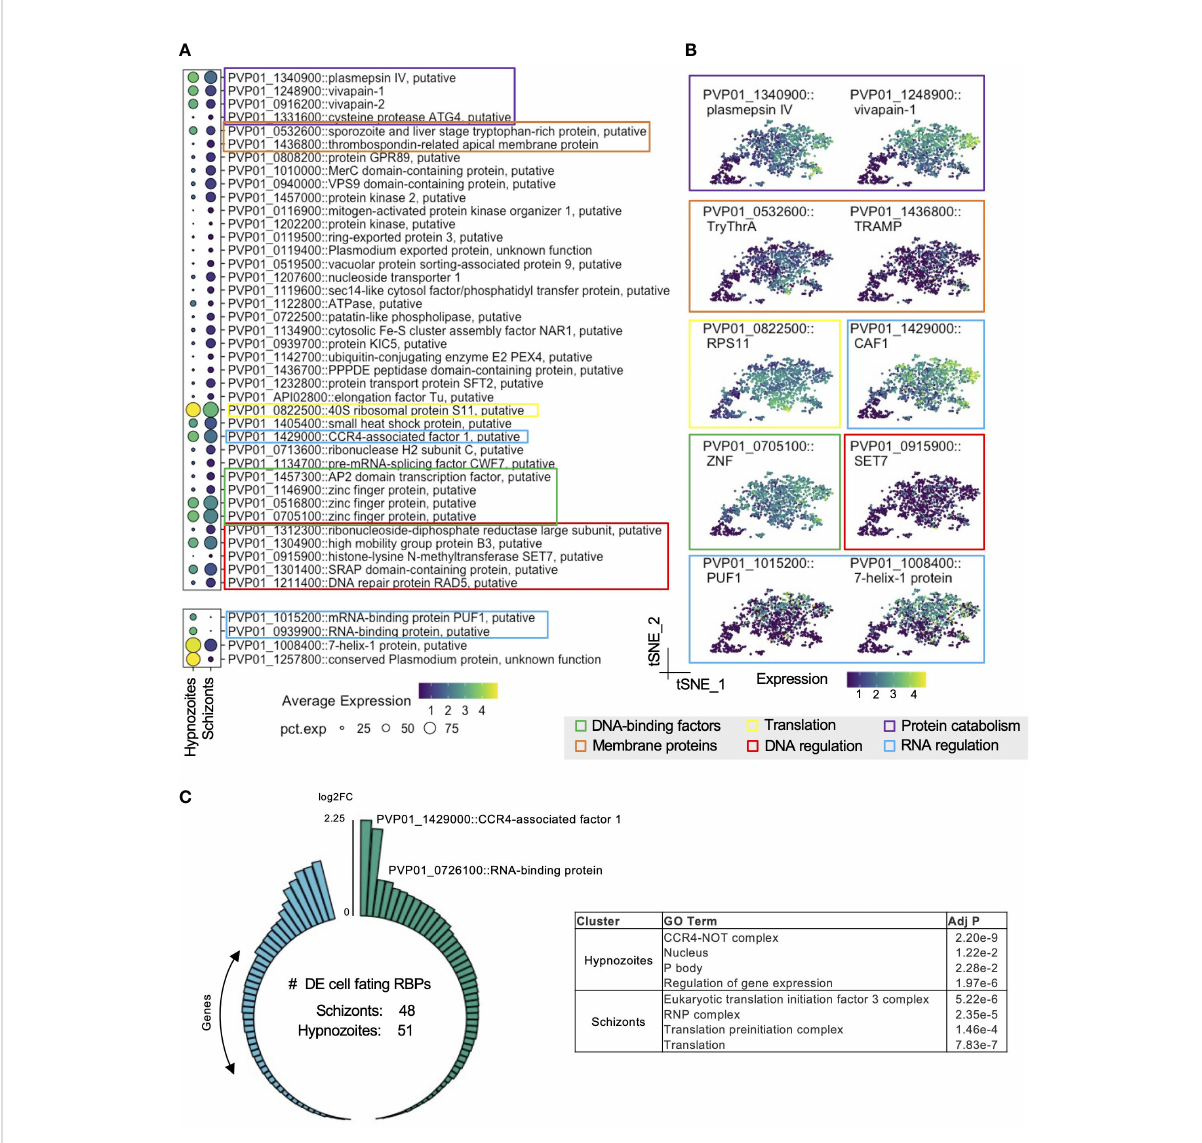
FIGURE 3 P. vivax hypnozoites have distinct transcriptomic signatures. (A) Dot plots showing transcripts that distinguish all hypnozoites from schizonts. The size of the dot corresponds to the percentage of cells that transcript was detected per condition, colored by average expression. Differentially expressed transcripts were identi fi ed using Seurat ’ s FindMarker function (Wilcoxon rank-sum test, Bonferroni adjusted p values < 0.01). (B) tSNE plots of liver stages colored by transcripts displaying greater levels in hypnozoites. Colored boxes in A and B indicate the family or canonical biological process that the transcript is associated with. Scale: normalized expression; pct. exp: percent of cells expressing transcript. (C) Number of transcripts in schizonts and hypnozoites identi fi ed as cellular fating RBPs (left) and GO term enrichment of this subset (right). Adj P: Bonferroni adjusted p